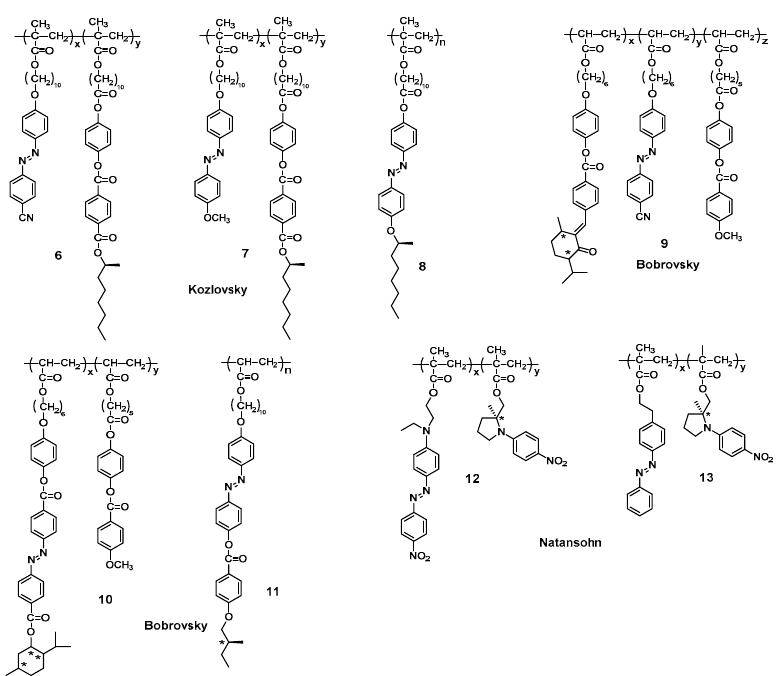
Figure 6. The chemical structures of chiral Azo-polymers 6, 7, 8, 9, 10, 11, 12 and 13.